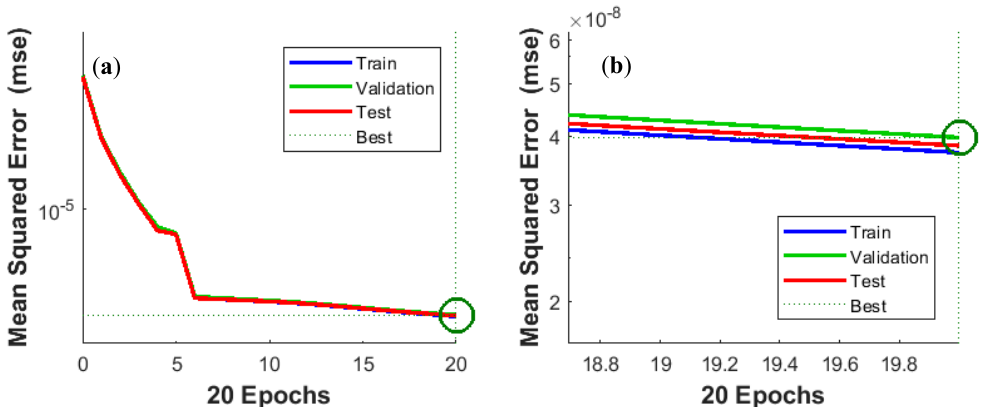
Figure 11. Best validation performance is 3.9897 × 10 − 8 at epoch 20: ( a ) general view, ( b ) enlarged view of the terminal part of the curve. Figure 12. ( a ) Error histogram with 20 bins, ( b ) gradient curve, ( c ) Mu curve.